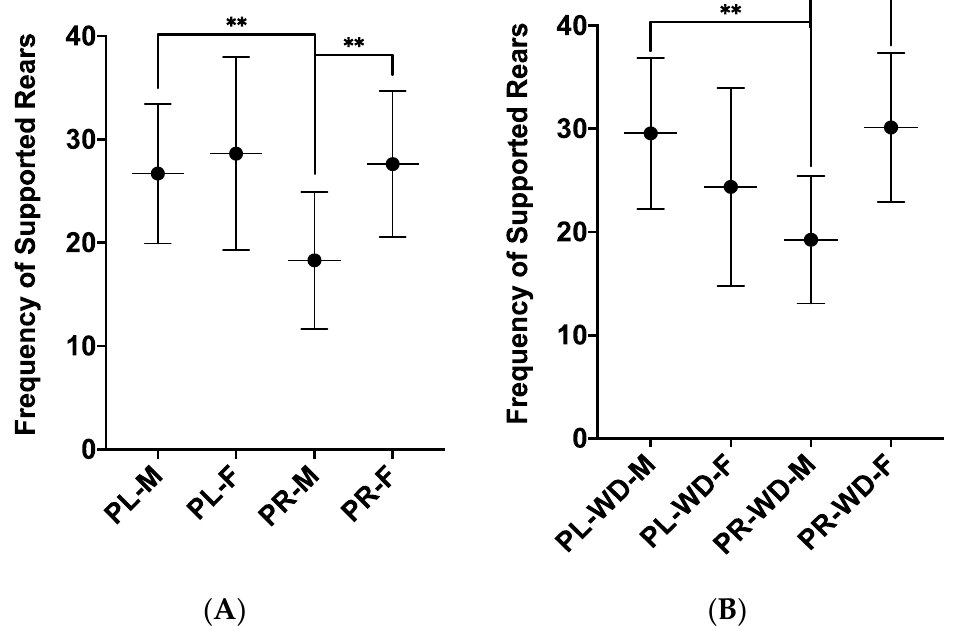
Figure 3. Supported rearing in the light–dark box for ( A ) the 2-way interaction between treatment and sex, and ( B ) the 3-way interaction between treatment, diet, and sex. Data expressed as M ( SD ). ** p < 0.01. PL: placebo; PR: probiotic; WD: Western diet; M: male; F: female.